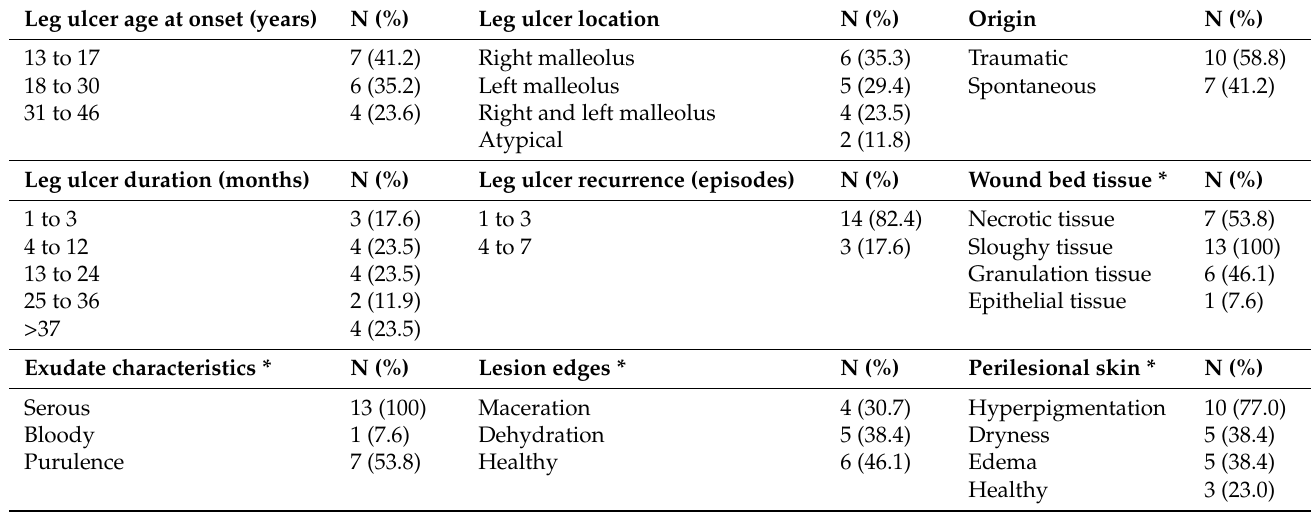
Table 1. Clinical characterization of SLU.